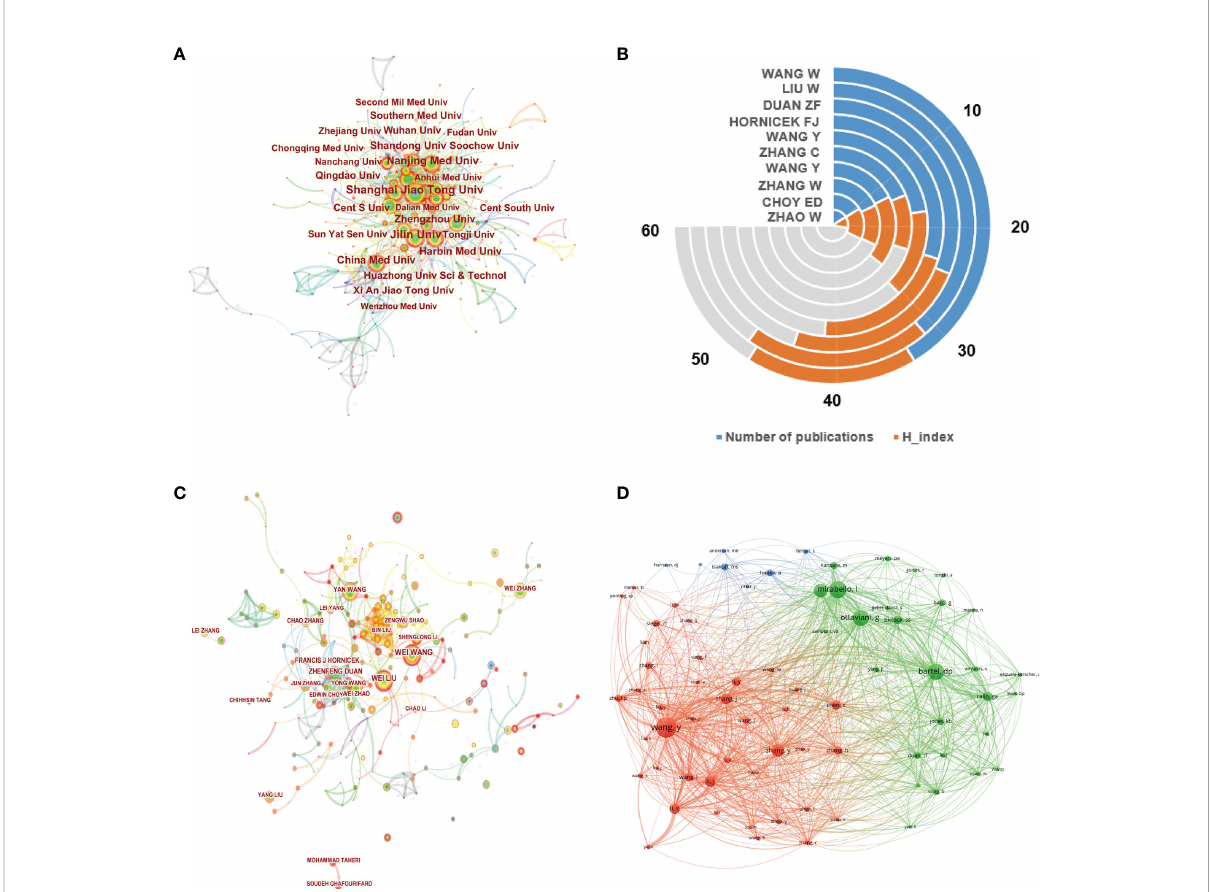
FIGURE 4 (A) Network map of institution co-authorship analysis based on CiteSpace. In the visualization map, each node represents an institution, and its size is proportional to the number of publications. The connecting line between nodes represents the strength of the cooperation relationship. (B) The total number of publications and H-index of top 10 productive authors in this fi eld. (C) The cooperation network map of productive authors generated by CiteSpace. The graphical explanations are the same as in A. (D) Author co-citation analysis by VOSviewer. Each node represents a different author, and node size indicates the quantity of citations. The connection between the nodes represents a citation relationship, and the thickness of the lines indicates citation